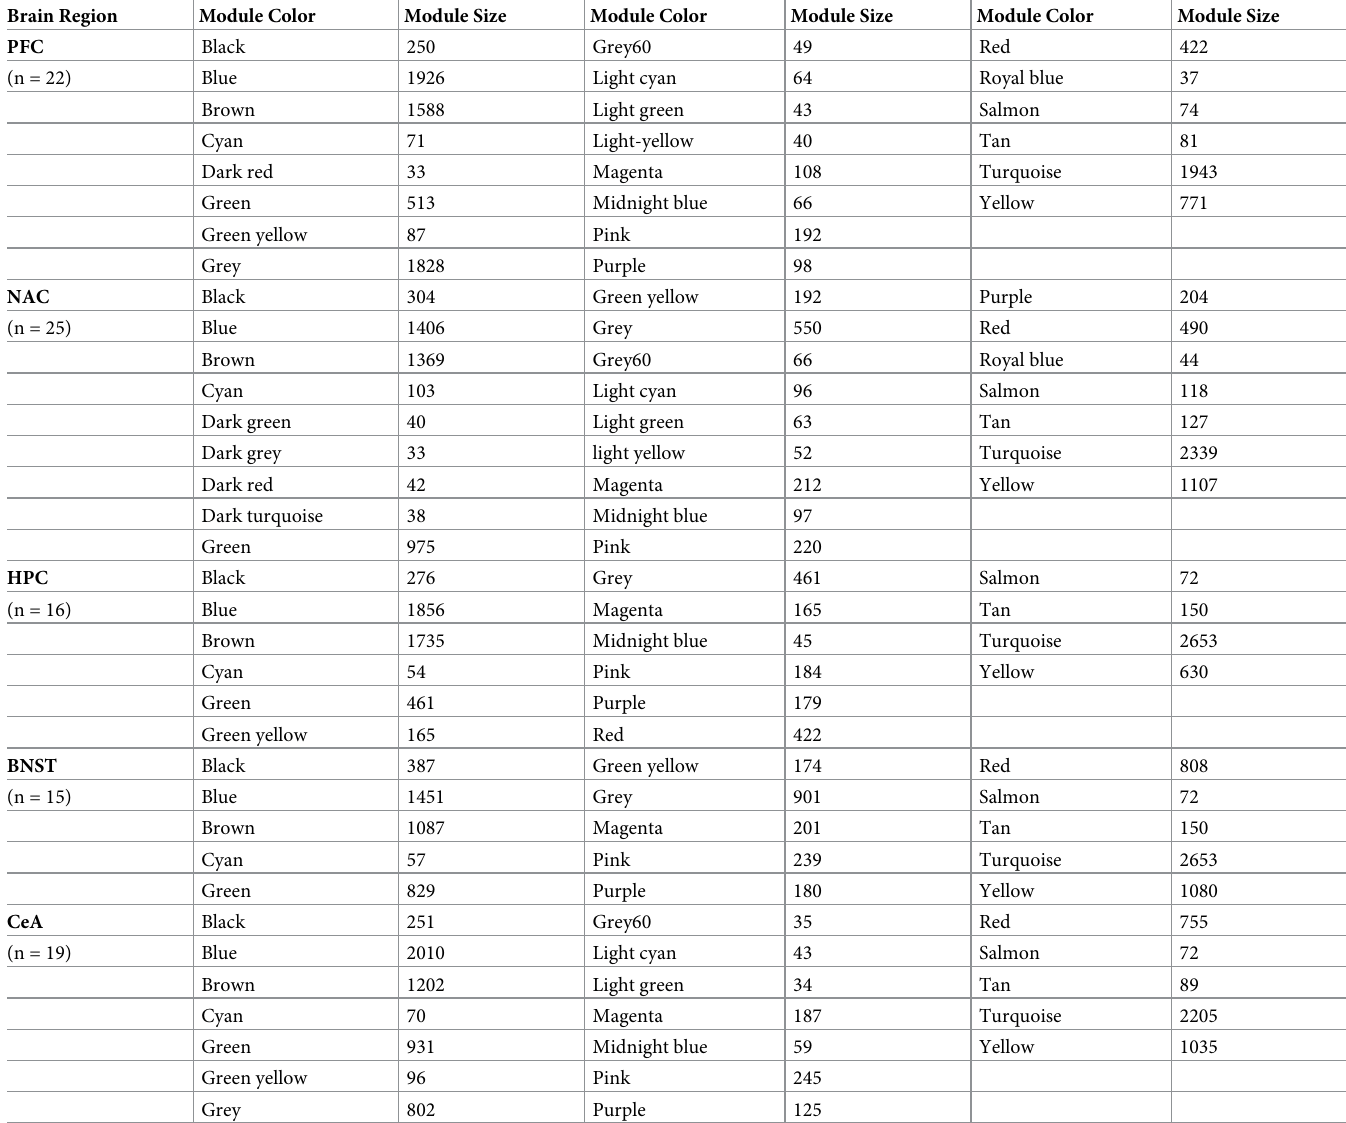
Table 2. Module names and sizes for each brain